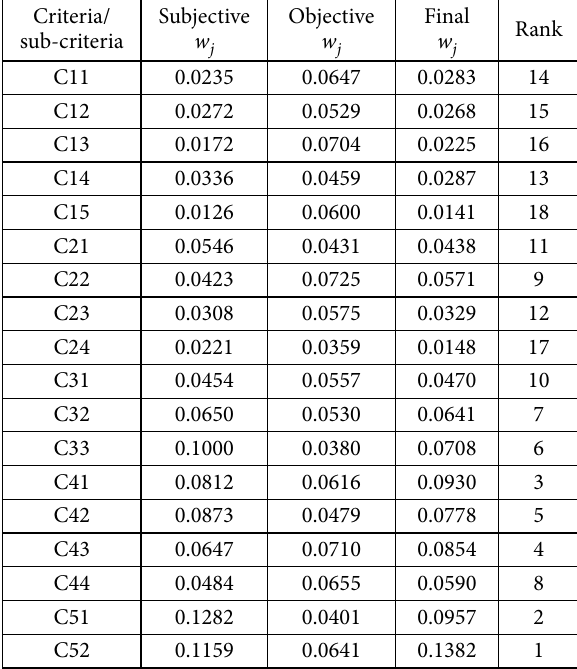
Table 6. The final values of the weight